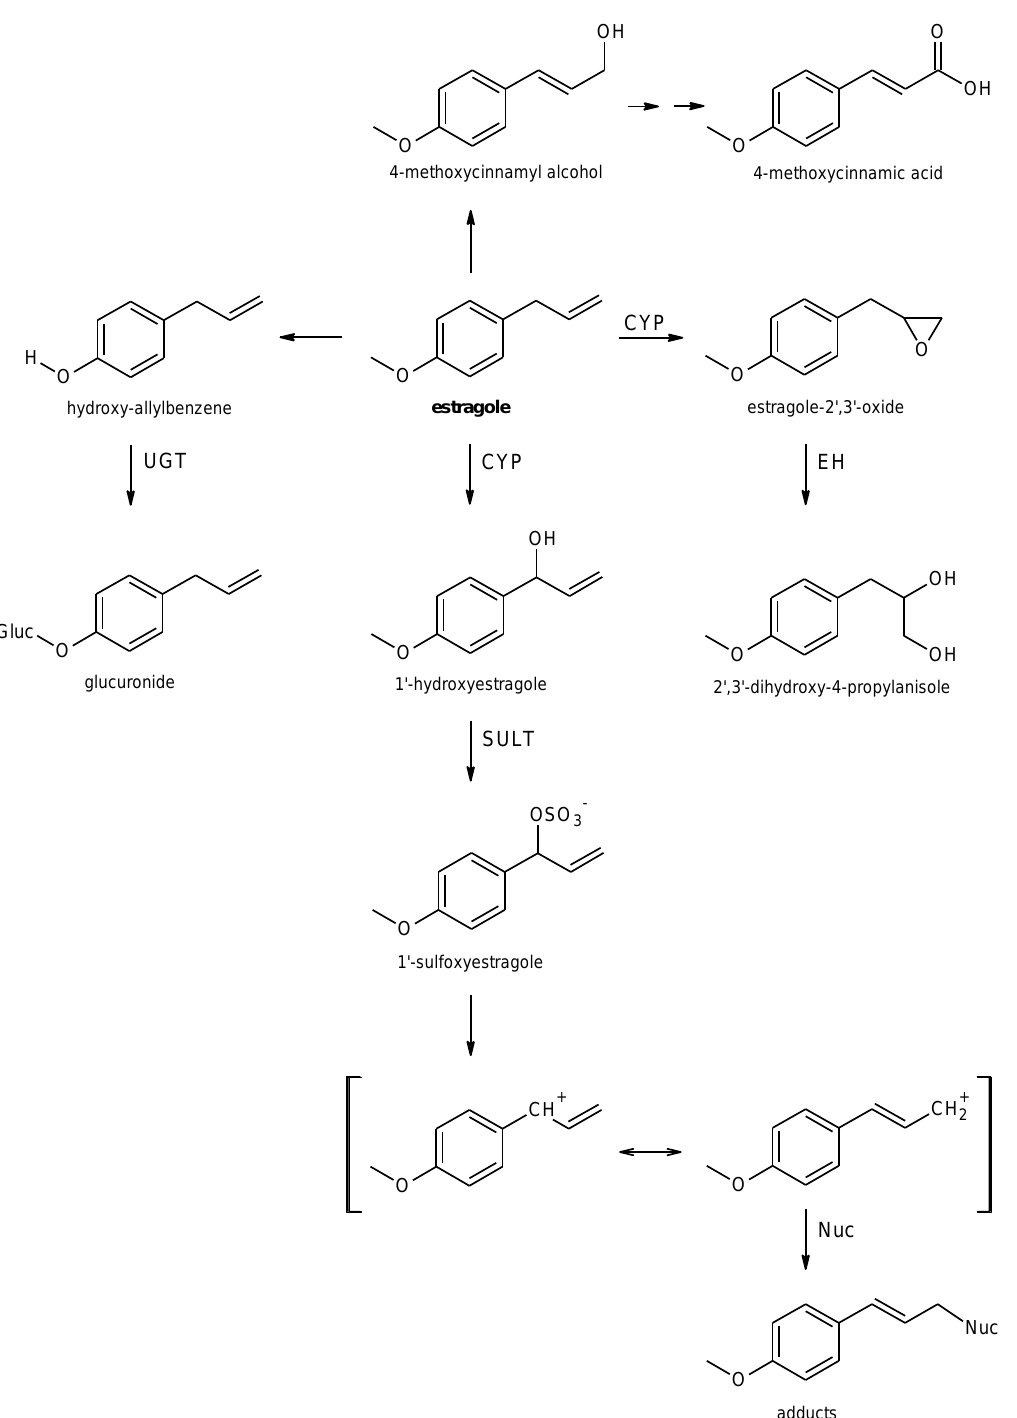
Figure 1. Important metabolic steps of estragole as an example for the allylalkoxybenzenes. CYP, cytochrome P450- monooxygenase; UGT, uridine 5′-diphospho-glucuronosyltransferase; EH, epoxide hydrolase; SULT, sulfotransferase; Nuc, nucleophile (e.g., DNA, protein).